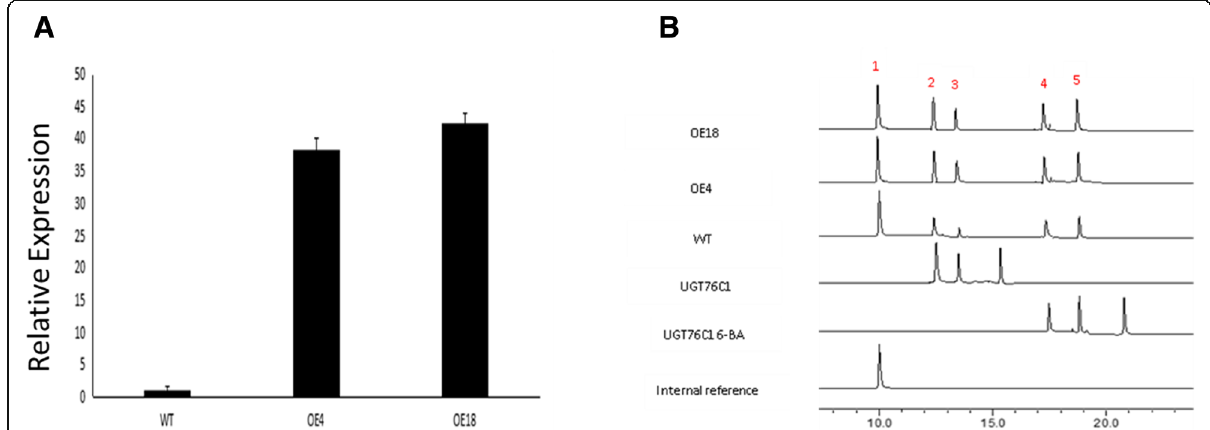
Fig. 6 Overexpression Os6 into Arabidopsis and determination their cytokinin glycosides. Overexpression of rice glycosyltransferase gene Os6 into Arabidopsis and determination of cytokinin glycosides in transgenic Arabidopsis. a . The relative expression of Os6 in Arabidopsis. b . The content of cytokinin glycosides in transgenic